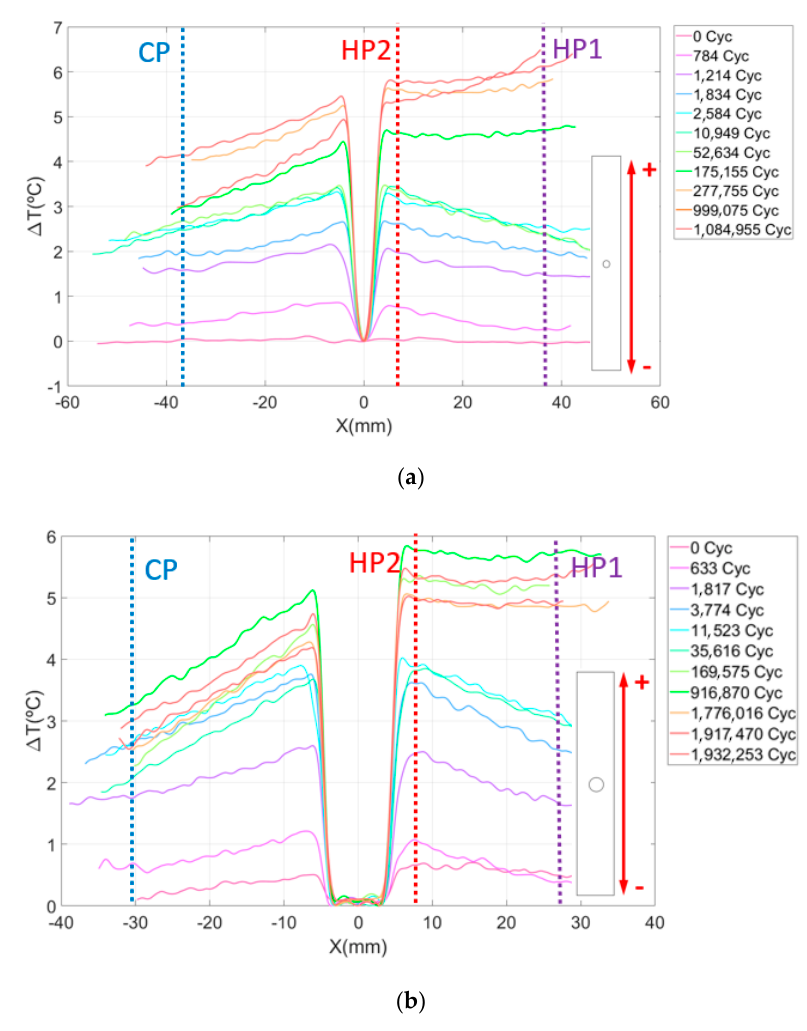
Figure 11. Evolution of the surface temperature variation as function of the number of load cycles in specimens cut at transversal direction for ( a ) geometry A and ( b ) geometry B.